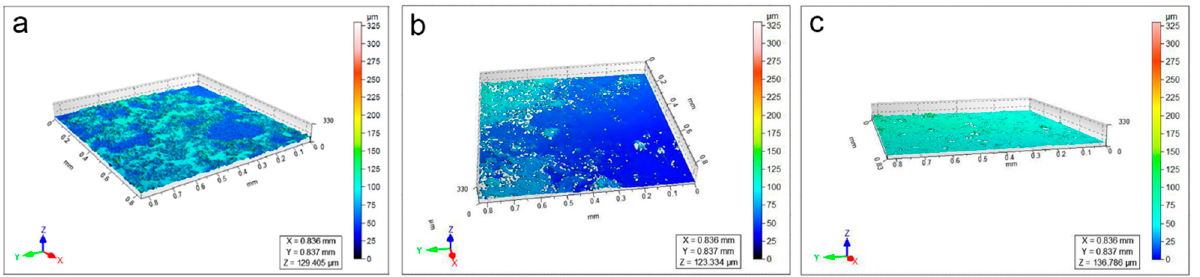
Figure 4. 3D heat maps of soiled-WM ( a ) cleaned by CA_3 ( b ) and KGB_3 ( c ). The colour range represents the different heights (in microns) of the details present on the sample surface.